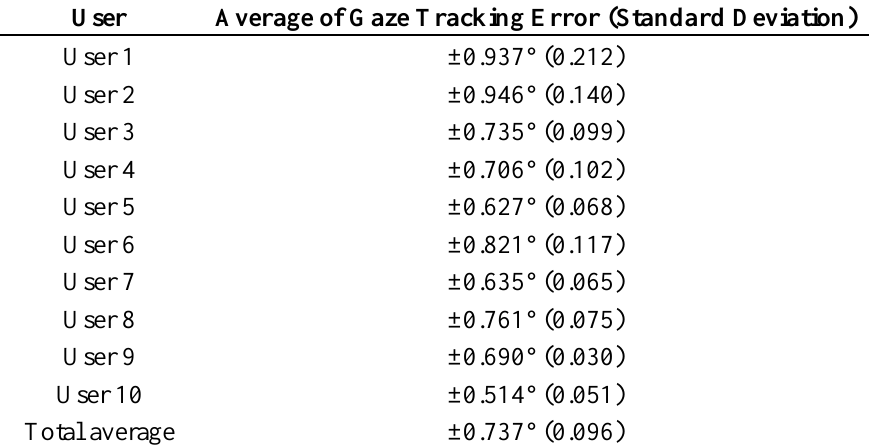
Table 1. Errors of proposed gaze tracking